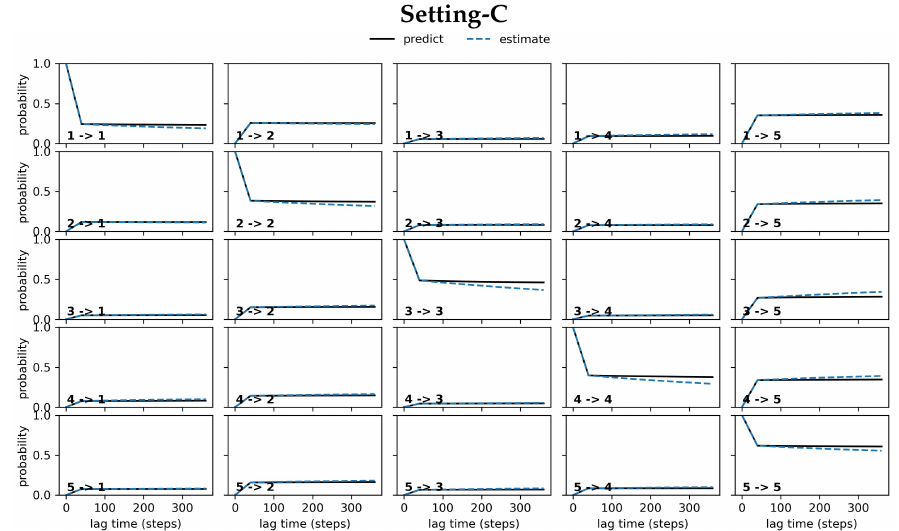
Figure 5. The CK test is carried out on each of the antigen-bound antibody MSM models obtained respectively from ( top panel) Setting-A, ( middle panel) Setting-B, and ( bottom panel) Setting-C. Deviations between the estimated and the predicted model are large in Setting-A, gradually reduce over Setting-B, and become negligible in Setting